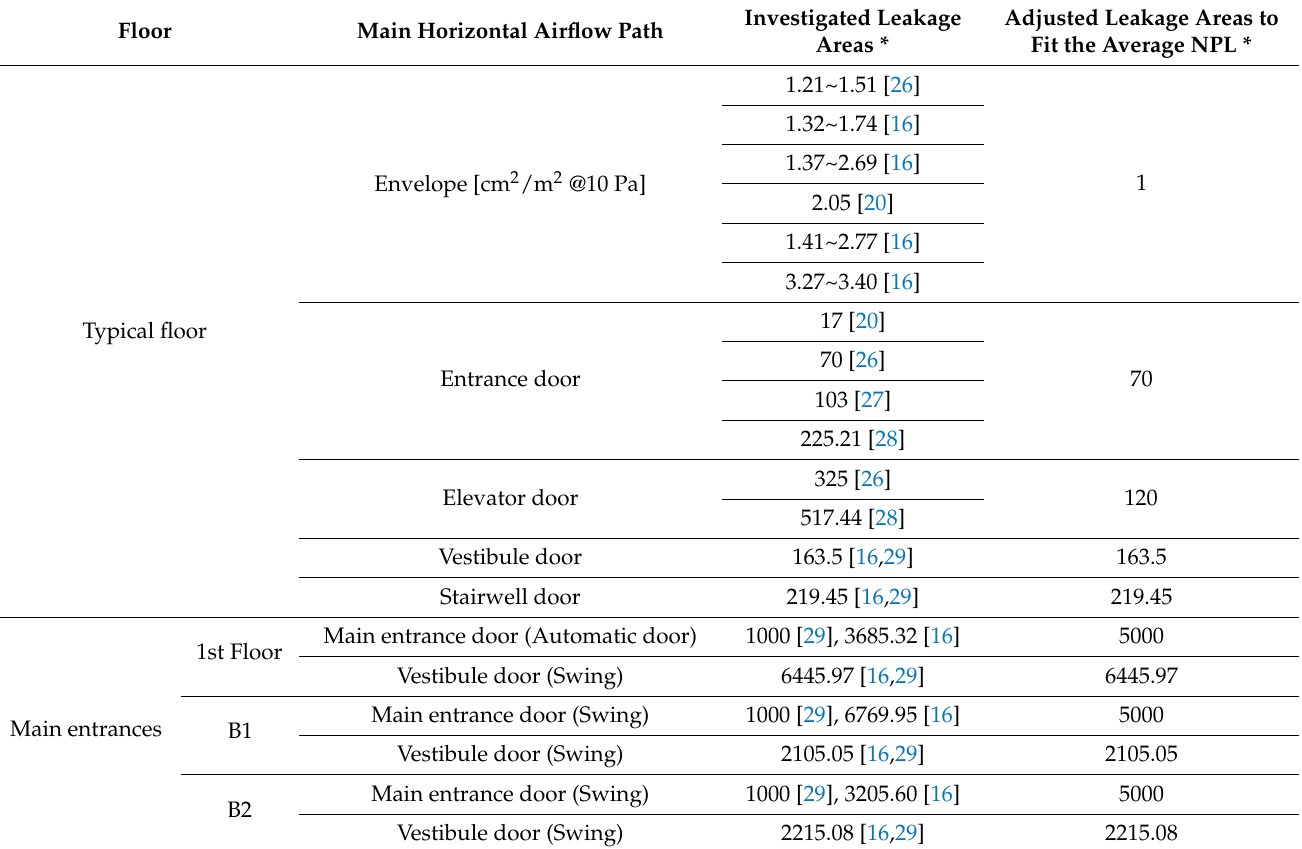
Table 1. Leakage area applied to theoretical model and simulation